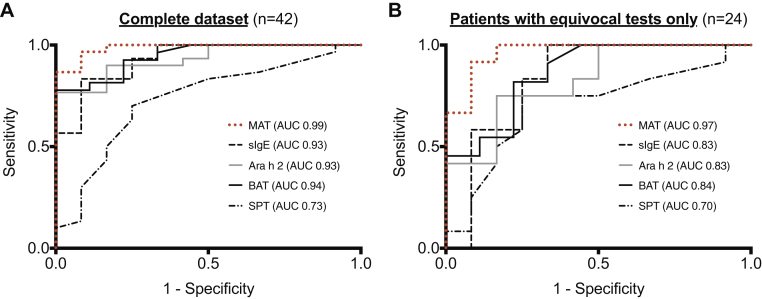
ROC curves comparing discrimination performance of the MAT with that of other diagnostic modalities in 42 peanut-sensitized subjects, of whom 30 reacted to less than 4.4 g of peanut protein with objective symptoms (A), and a subgroup of peanut-sensitized subjects with equivocal results for conventional allergy tests (B). In both scenarios the MAT had the most favorable diagnostic accuracy compared with other tests in identifying those with clinical reactivity to peanut.